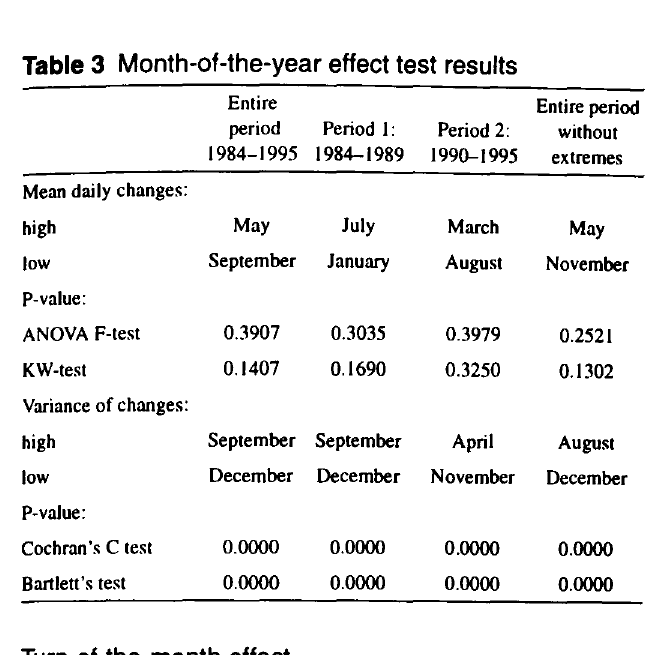
Table 3 Month-of-the-year effect test results